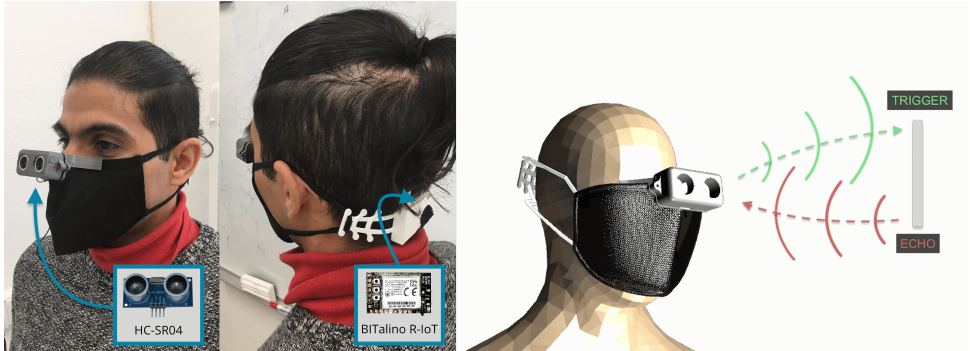
Figure 1. Proximity sensor enclosure fitted onto the face mask with trigger (output) and echo (receiver)